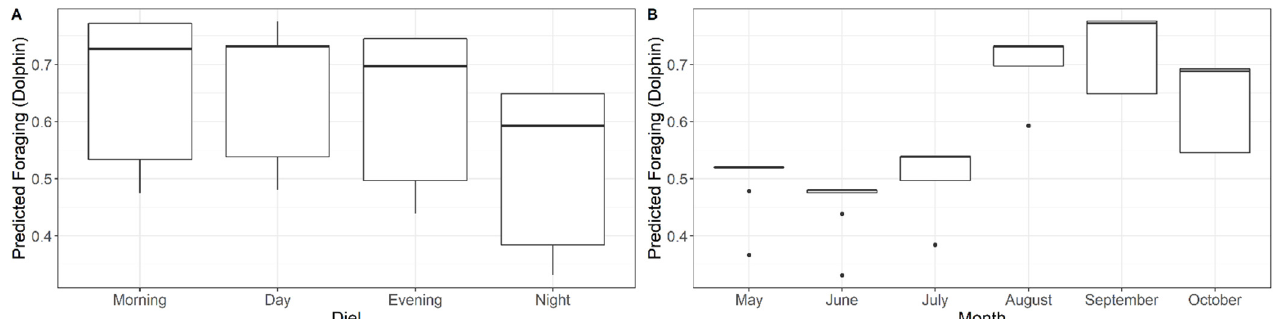
Figure 4. FPH-based binomial GLM. The predicted probability of dolphin foraging at Brandon Bay according to: ( A ) the time of day, where the four categories of diel phase are “Morning”, “Day”, “Evening”, and “Night”; ( B ) Month, from May to October. Predicted foraging is measured by the proportion of foraging positive hours, which are hours containing at least one click train with a minICI < 10 ms.